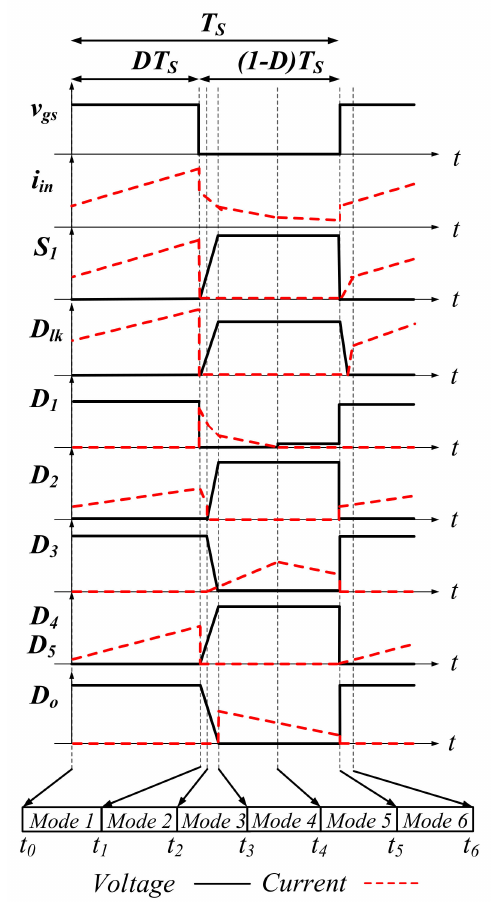
Figure 3. The key waveforms of the proposed